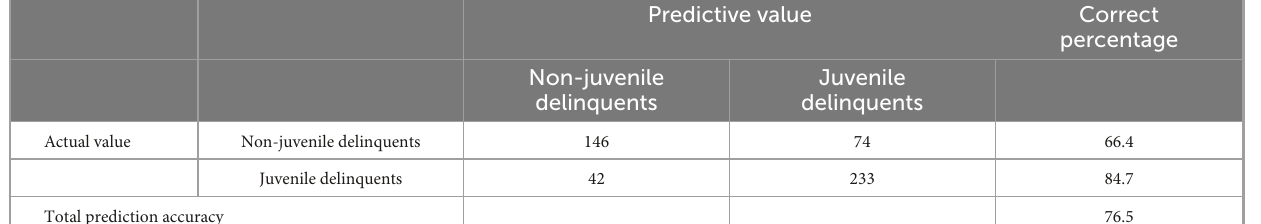
TABLE 8 Crosstab of predictive classification accuracy.